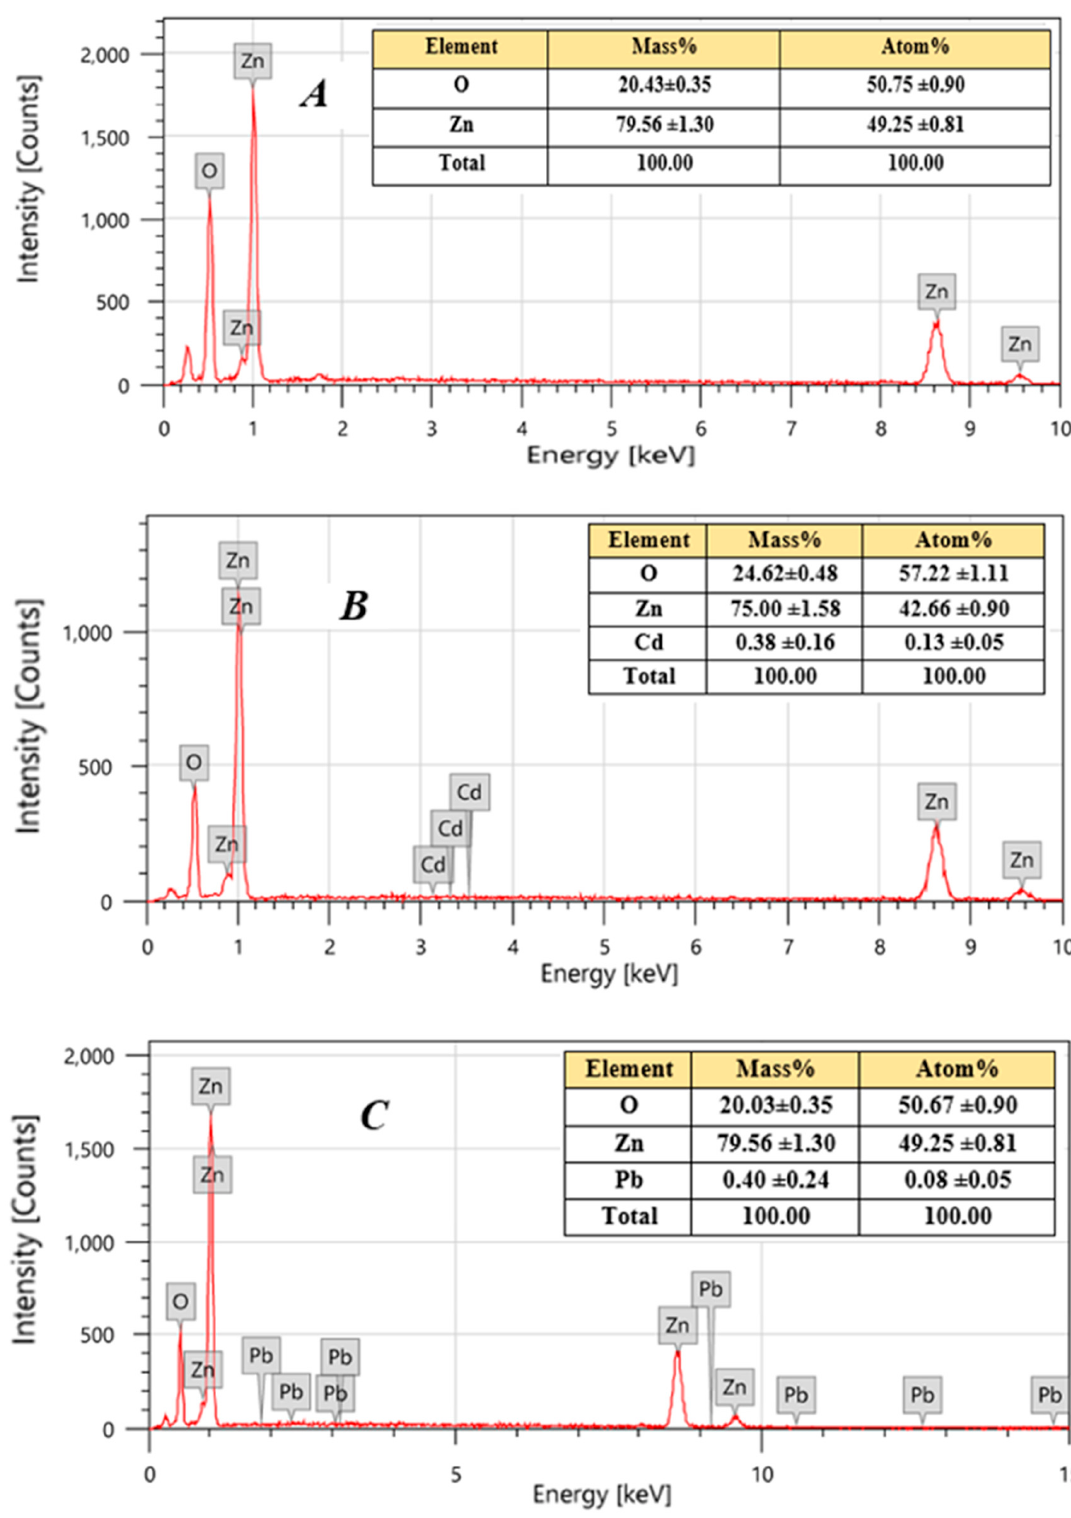
Figure 4. EDX profile of ( A ) the synthesized ZnO-NPs, ( B ) ZnO-NPs-Cd, and ( C ) ZnO-NPs-Pb.